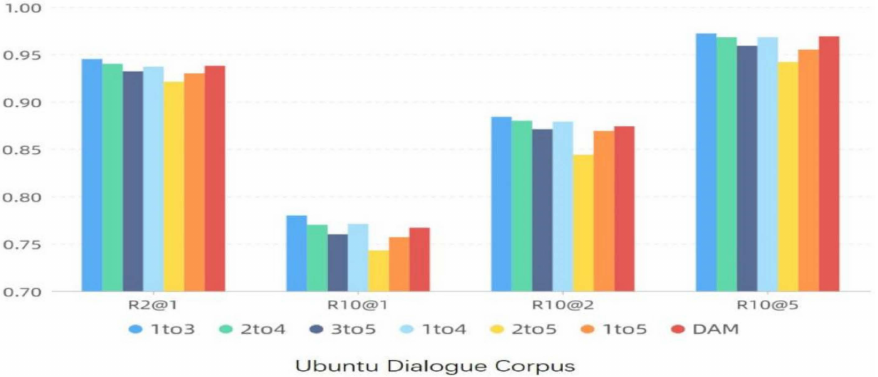
Figure 7. Comparison test results of granularity size layer selection (Ubuntu Dialogue